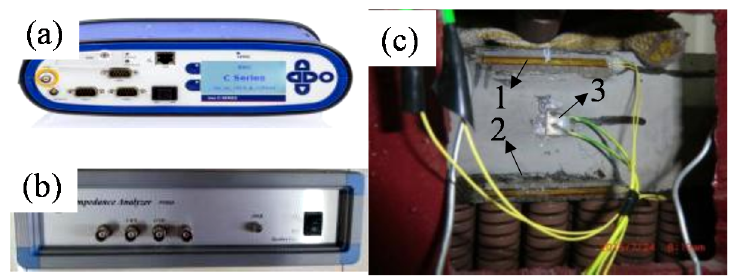
Figure 6. Monitoring and data collection system. ( a ) IMC dynamic strain collecting instrument, ( b ) PV80A impedance analyzer, ( c ) Layout of the monitoring point- 1, upper strain gauge; 2, lower strain gauge; 3, piezoelectric ceramic patch. Table 4. Monitoring equipment.